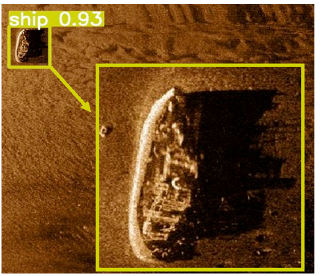
Figure 21. Detection on real data (Without Style transfer).